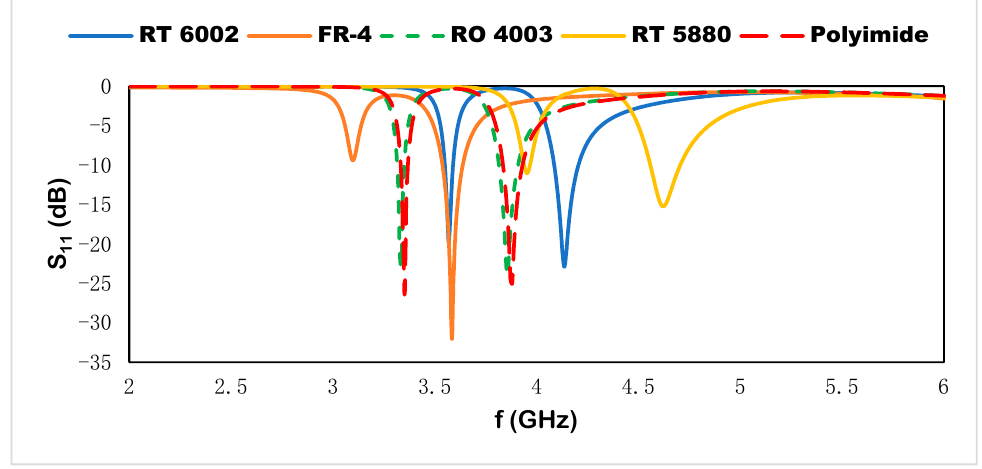
Figure 12. Different substrates as a host medium of the sensor. Table 3. Dielectric constant and resonant frequencies with depth notch for the different substrates. Dielectric Constant